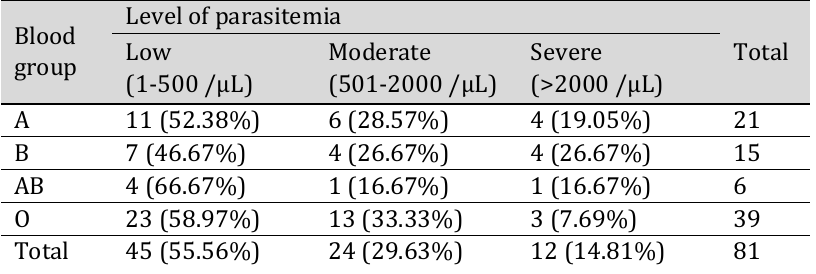
Table 3. Malaria Parasite density in relation to blood groups of the participant pregnant